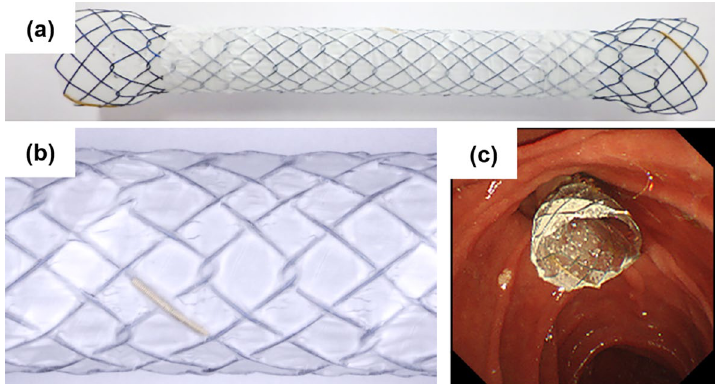
Figure 1. A novel fully covered SEMS with inner and outer PTFE coating and dumbbell-shaped flares. ( a ) Both the inside and outside of the metal mesh are coated with PTFE, and both ends of the stent have dumbbell- shaped flares. ( b ) The stent body has a nitinol-based braided hook-cross wire structure with a compositional ratio of cross and hook portions of 4–1. ( c ) The distal flare with a diameter 4 cm larger than that of the stent body allows anchoring to the duodenal papilla and reduces sludge accumulation. EMS Self-expandable metal stent, PTFE Polytetrafluoroethylene.